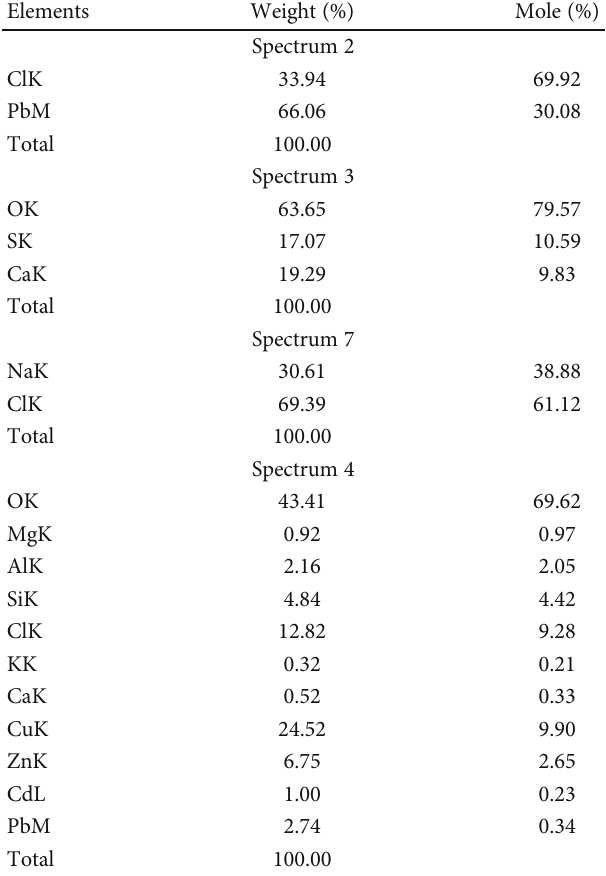
Table 4: The concentration of elements on grains in SEM of Figure 5. Elements Weight (%) Mole